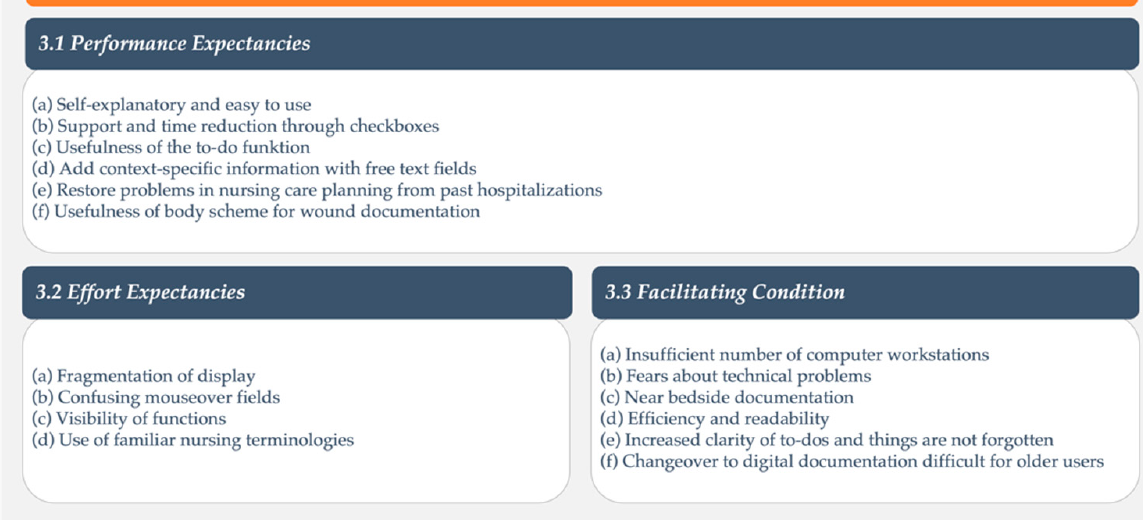
Figure 2. Overview of the main categories and subcategories based on UTAUT.